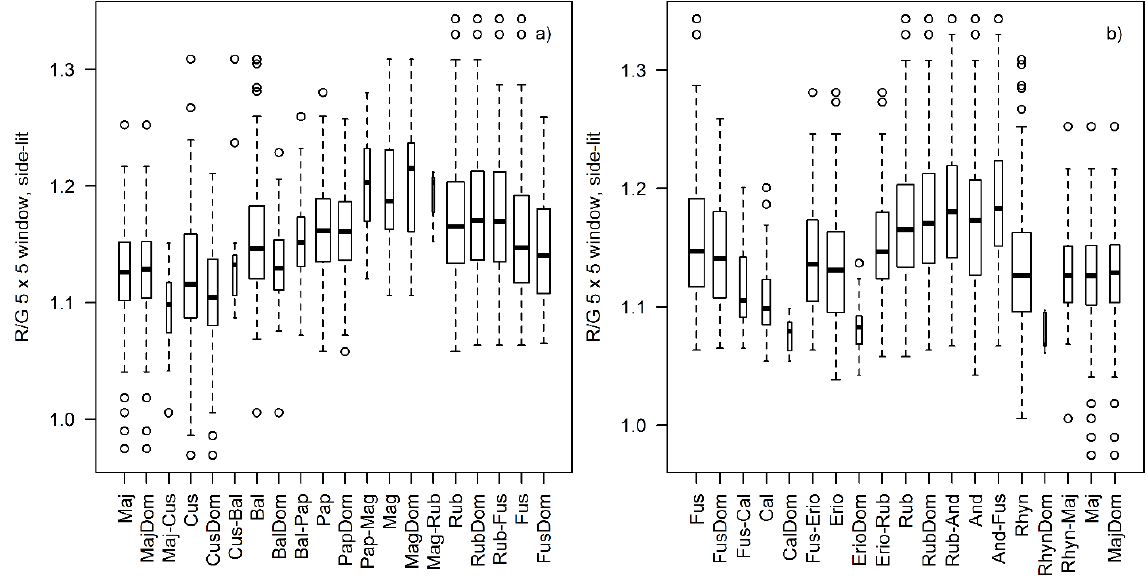
Figure 11. Boxplot comparison of the RED/GRN image feature in plots vegetated by (a) Sphagnum mosses only and (b) Sphagnum mosses with field layer vegetation. The labels ‘XXX’, ‘XXXDom’, ‘XXX-YYY’ are interpreted as 'Species XXX is found', 'Species XXX dominates' and 'Both XXX and YYY are found', respectively. Abbreviations are given in Table 2. Azimuth difference is limited to 90° ± 45° (stratum) to constrain the directional effects. Note that groups are not limited and, for example, S. balticum can occur in groups ‘Maj’, ‘MajDom’, ‘Maj-Cus’,